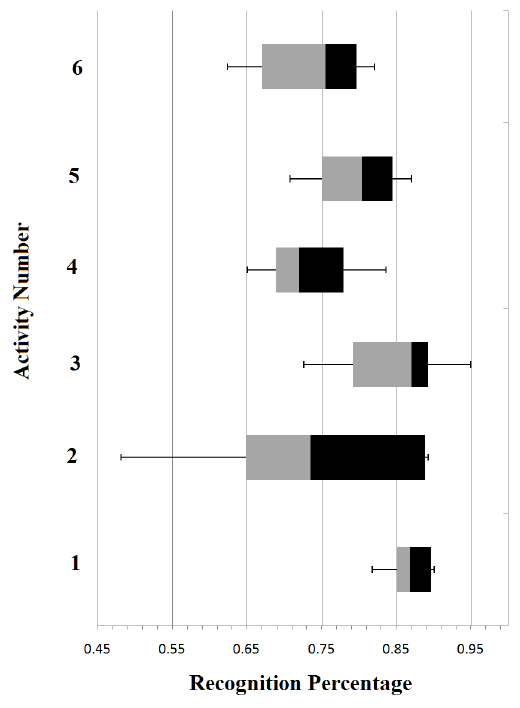
Figure 9: Distribution for the recognition rate between all CASAS and MavHome .